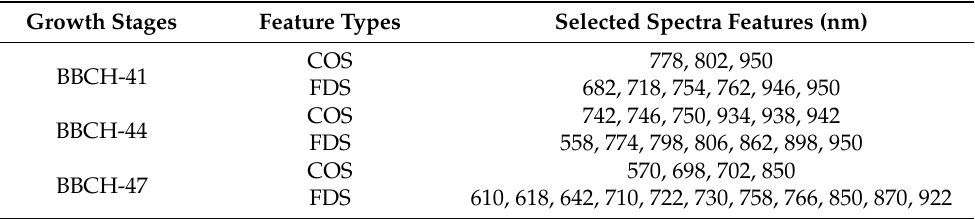
Table 3. COS and FDS features selected by GPR-BAT for the tuber-formation, tuber-growth, and starch-storage